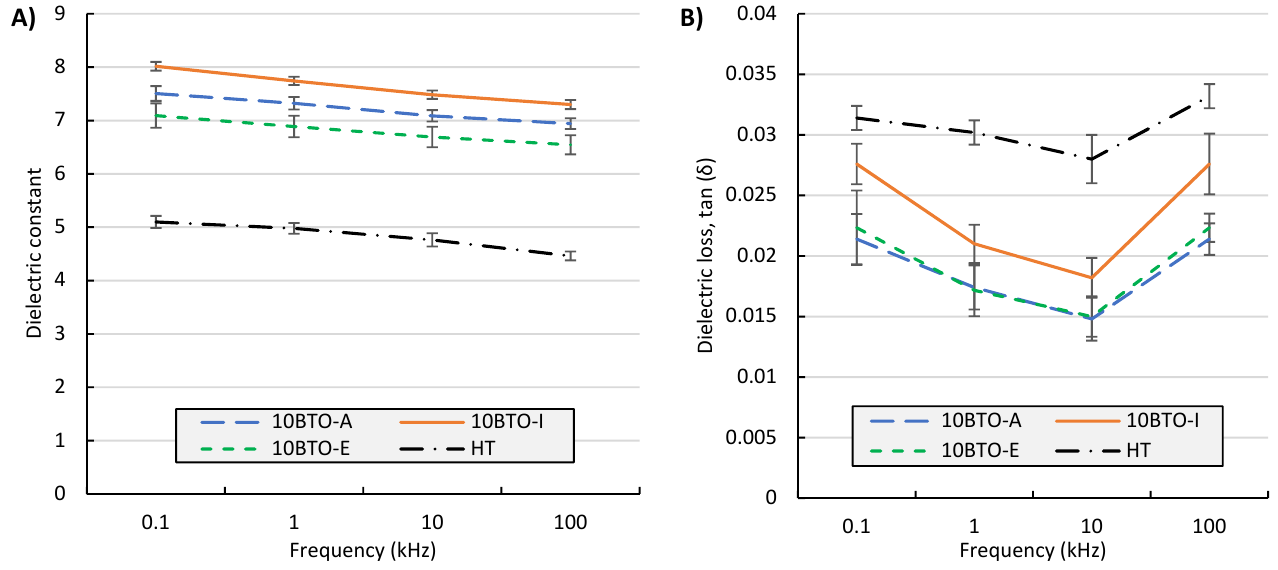
Figure 6. Dielectric properties of 10 vol.% BTO/photopolymer suspensions dispersed with different solvents: ( A ) dielectric constant; ( B ) dielectric loss.